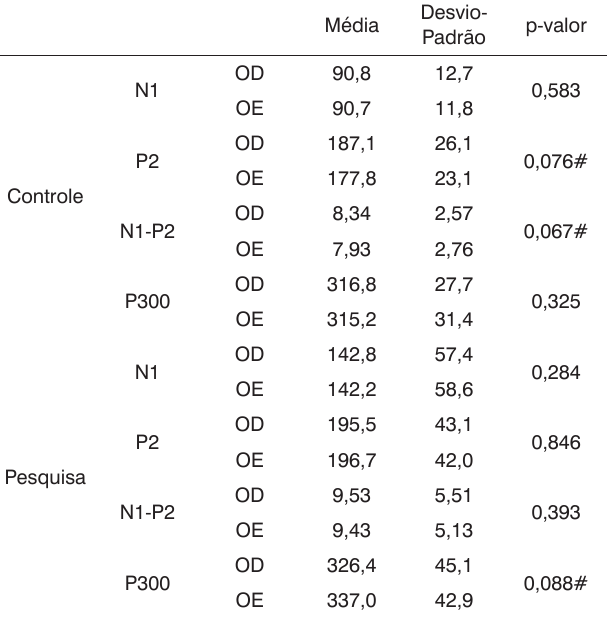
Tabela 1. Comparação dos valores médios das latências dos com- ponentes N1, P2, P300 (em ms) e da amplitude N1-P2 (em µv), entre as orelhas direita e esquerda, nos grupos controle e pesquisa.